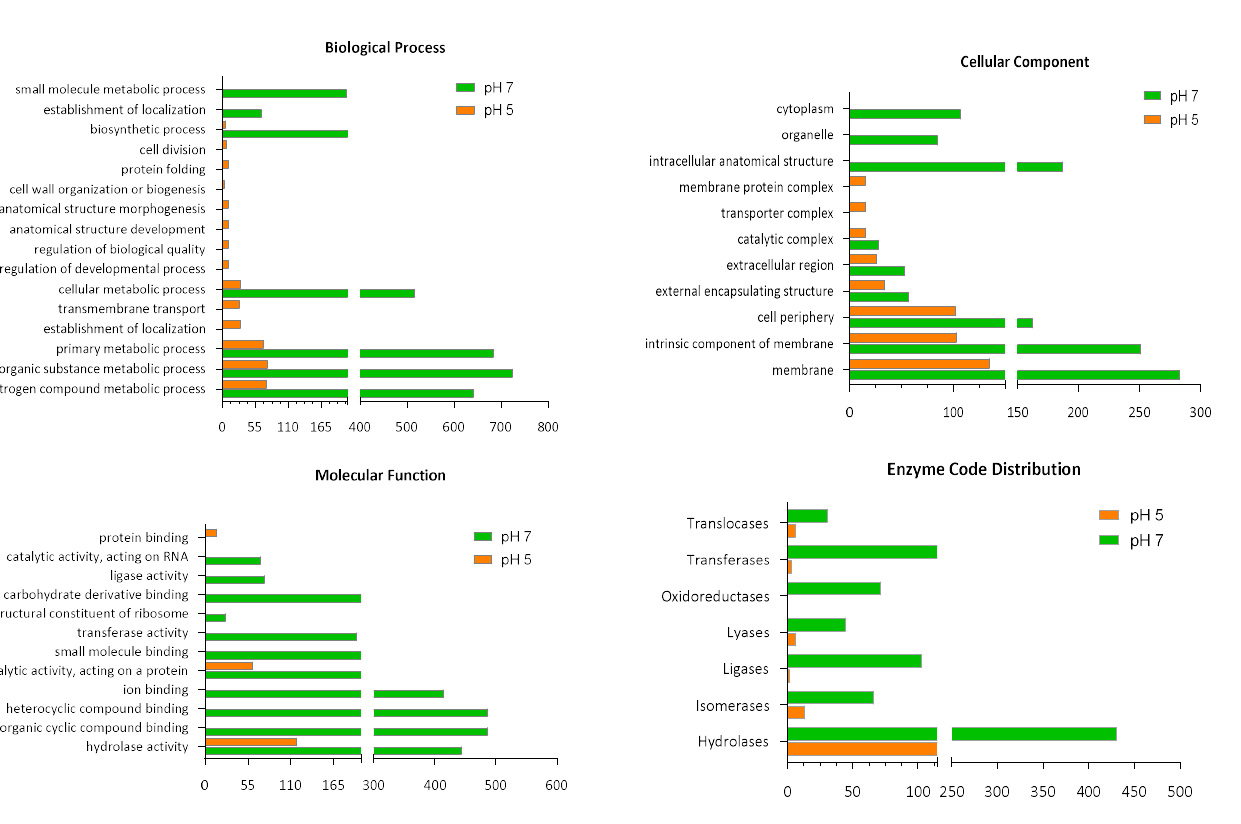
Figure 2. Variation in biological processes, cellular components, molecular function, and enzyme code distribution of the proteins based on the GO enrichment analysis of L. helveticus obtained from CFS when cultured at pH 5 and 7.